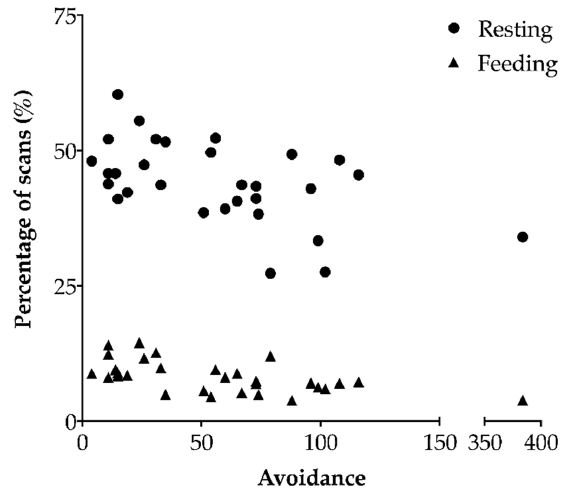
Figure 3. The relationship between each regrouped heifer’s avoidance level (n = 30) and the percentage of scans they were recorded feeding or resting (samples were taken every five minutes). Agonisticbehaviors were recorded continuously during the first 24 h after heifers were introduced into a new group. More avoidant heifers spent less time feeding (Wald test on a linear mixed-e ff ects model with host group as a random e ff ect; p = 0.0014) and less time resting ( p = 0.01). No relation was found between avoidance and time spent resting. The extreme point for avoidance was capped in the model at the second highest value +